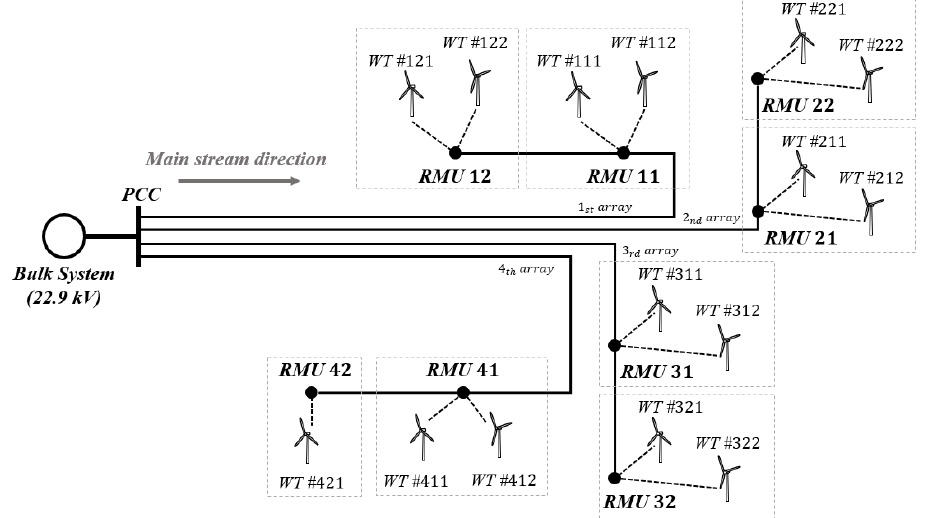
Figure 3. Reconfigured Dongbok wind farm structure.